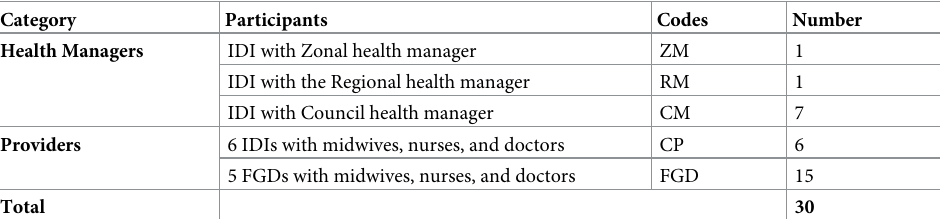
Table 9. Interviewed participants and their